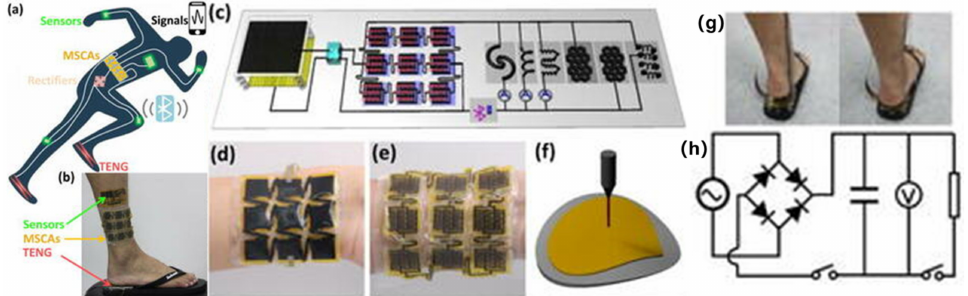
Figure 4. Human motion-driven self-powered sensing system. ( a – c ) Schematic illustration and optical images of the LIG-based self-powered, wireless, wearable sensing platform, with the energy harvested by TENGs from kinetic human motion to charge MSCAs as the sustained power supply for powering on-skin sensors, signal processing units, and wireless data transmission components. ( d ) Photo of the stretchable LIG-based top electrode with island-bridge layout in the TENG. ( e ) Photo of the stretchable LIG-based MSCAs attached on a human wrist. ( f ) Schematic illustration of the laser inducing process. ( g ) Photo of the LIG-based TENG shoe sole incorporated into a flip-flop. ( h ) Circuit diagram of the LIG-based TENG shoe sole. Reproduced with permission from [15]. Copyright 2022 AIP